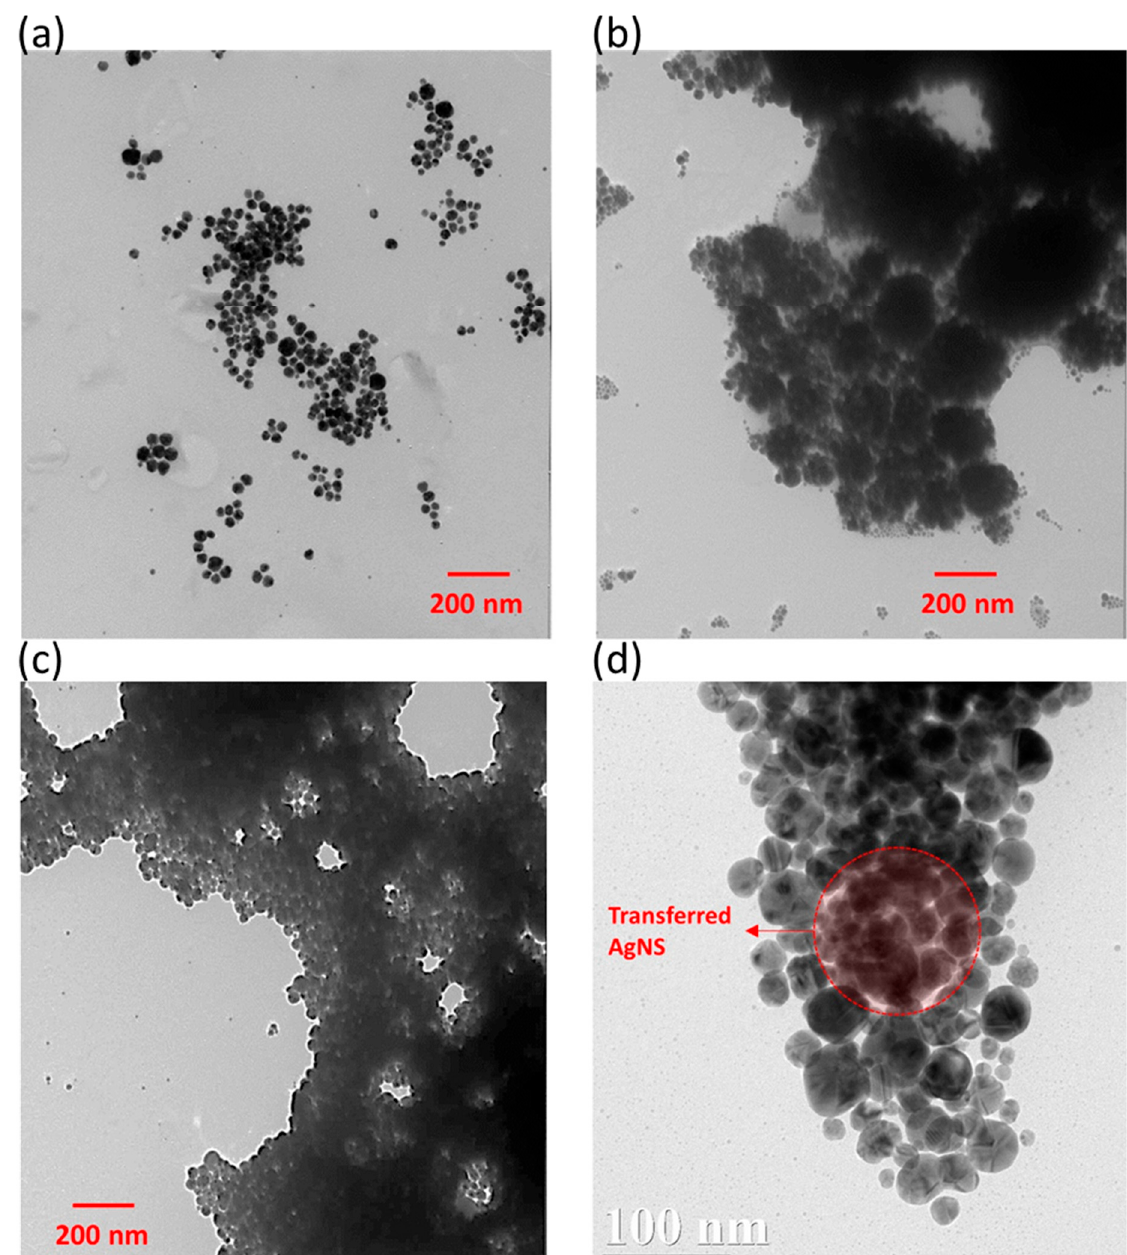
Figure 2. TEM images of AgNCs and AgNSs before / after phase transfer. ( a ): AgNCs, ( b ): AgNSs before phase transfer, ( c ): Transferred AgNSs, ( d ): Transferred AgNSs with high resolution).